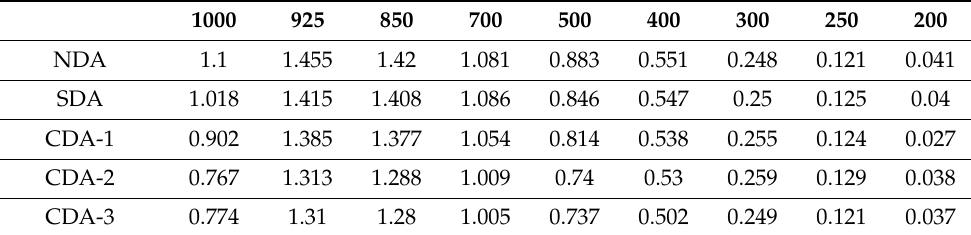
Table 3. The humidity root mean squared error (RMSE) (g/kg) of 24 h forecasts verified against ERA-5 data at different levels (hPa).